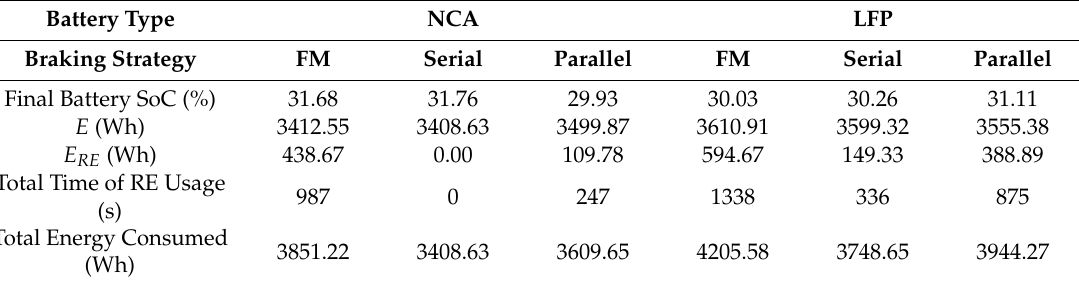
Table 6. Results for the 20 kg RE case for the first route.